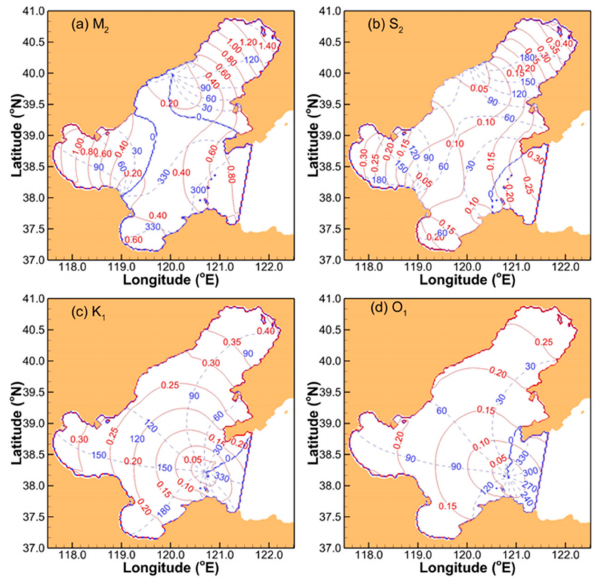
Figure 2. Predicted co-amplitude (red solid lines) and co-phase (blue dash lines) maps of major tidal